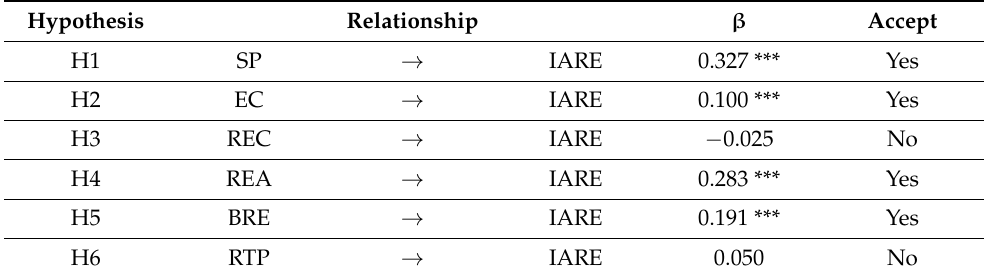
Figure 2. Evaluation of the SEM Model. The SEM model was evaluated for its fitness and the results were obtained were as follows. The chi-square statistic for the model was significant ( χ 2 [593] = 1315.745, p < 0.01). The χ 2 /df ratio = 2.128 was below 3.0 and was influenced by the sample size [45,47]. The CFI was 0.944; TLI was 0.938; IFI was 0.945, and NFI was 0.901, which provided an excellent fit since the values were greater than 0.9 or close to 1.0. Additionally, the RMSEA was 0.048 (below the threshold of 0.80) [51]. These findings clarify that the model fitted well with the data and was suitable for evaluating the hypothesis of the study. The findings of the study are summarised in Table 3 below. Table 3. Evaluation of Study